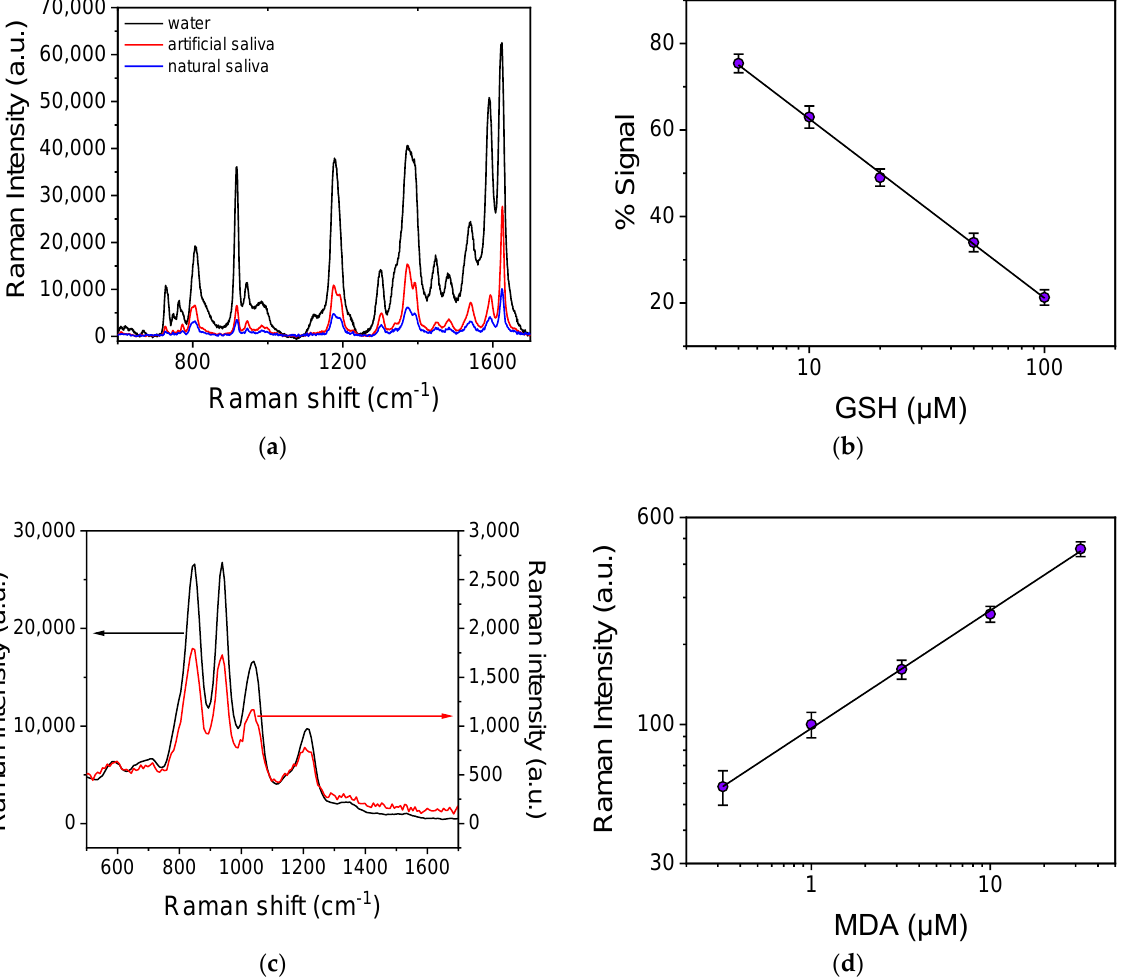
Figure 7. ( a ) Raman spectra obtained from SiNWs/Ag nanoparticle substrates modified with CV and then reacted with a zero-GSH calibrator prepared in water (black line) or artificial saliva (red line), as well as with a natural saliva sample (blue line). ( b ) GSH calibration curve obtained with calibrators prepared in artificial saliva. Each point corresponds to measurements obtained from 5 substrates (3 different spots per substrate) ± SD. ( c ) Raman spectra obtained from SiNWs/Ag nanoparticles substrates reacted with a 32 µ M MDA calibrator prepared in water (black line) or artificial saliva (red line). The arrows indicate which y-axis corresponds to each spectrum. ( d ) MDA calibration curve obtained with calibrators prepared in artificial saliva. Each point corresponds to measurements obtained from 5 substrates (3 different spots per substrate) ± SD.